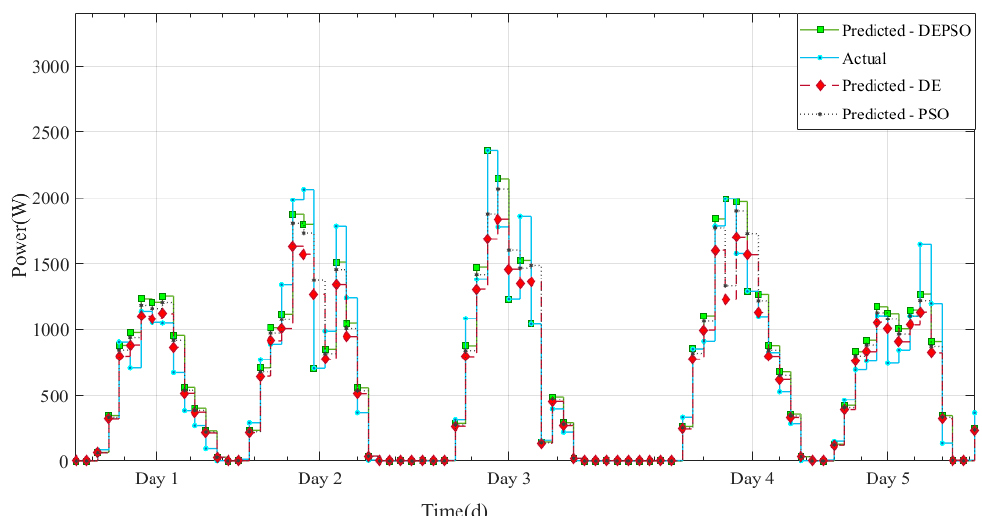
Figure 18. Comparison of DE-, PSO-, and DEPSO-forecasted values with actual value of PV output power.